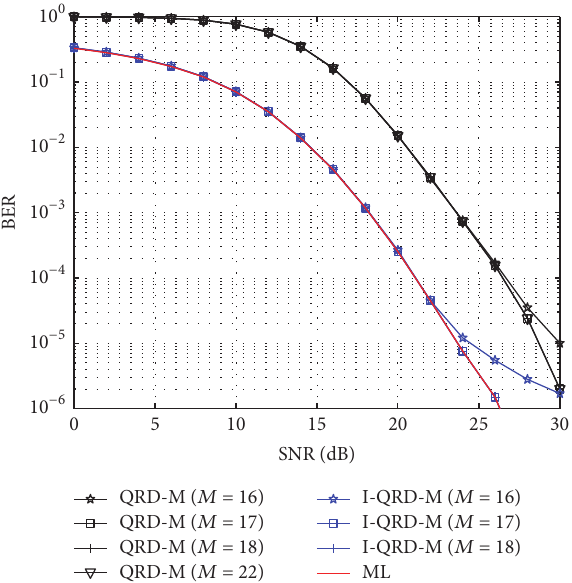
Figure 3: BER comparison for GSM scheme with 𝑁 𝑡 = 4 , 𝑁 𝑟 = 4 , and 𝑁 𝐴 = 3 for